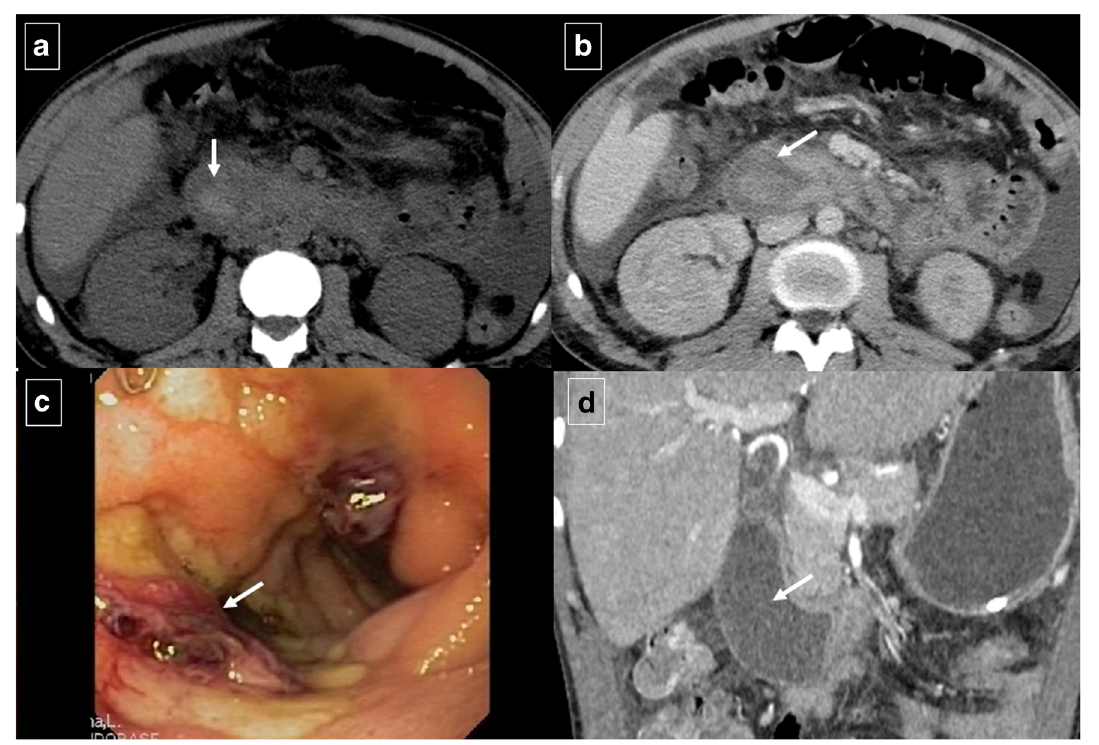
Fig. 22 Intramural duodenal hematoma in a 28-year-old man with a history of cocaine abuse. a Unenhanced CT shows a spontaneous hyperdense thickening of the duodenal wall (arrow). b Axial contrast- enhanced CT shows a heterogeneous and intramural duodenal masslike appearance (arrow). c Detail of the endoscopic study in the initial